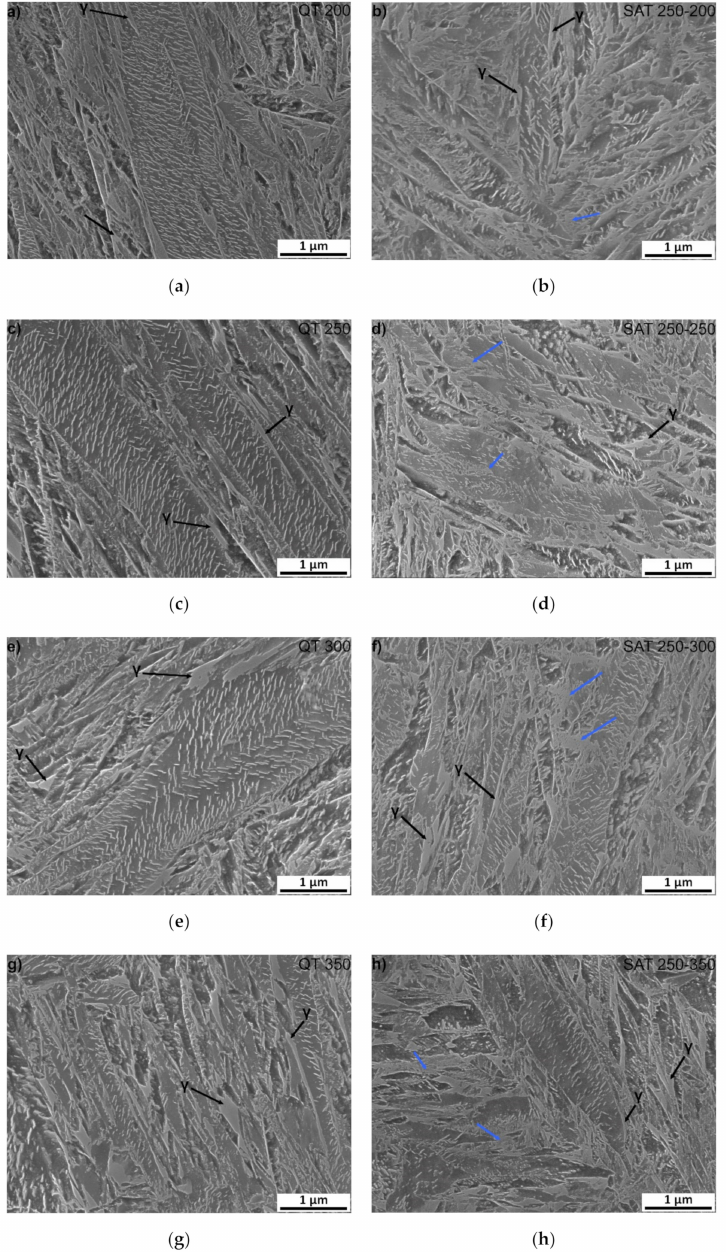
Figure 5. SEM microstructure of: ( a ) QT 200; ( b ) SAT 250–200; ( c ) QT 250; ( d ) SAT 250–250; ( e ) QT 300; ( f ) SAT 250–300; ( g ) QT 350 and ( h ) SAT 250–350. Blue arrows indicate bright islands with the lower